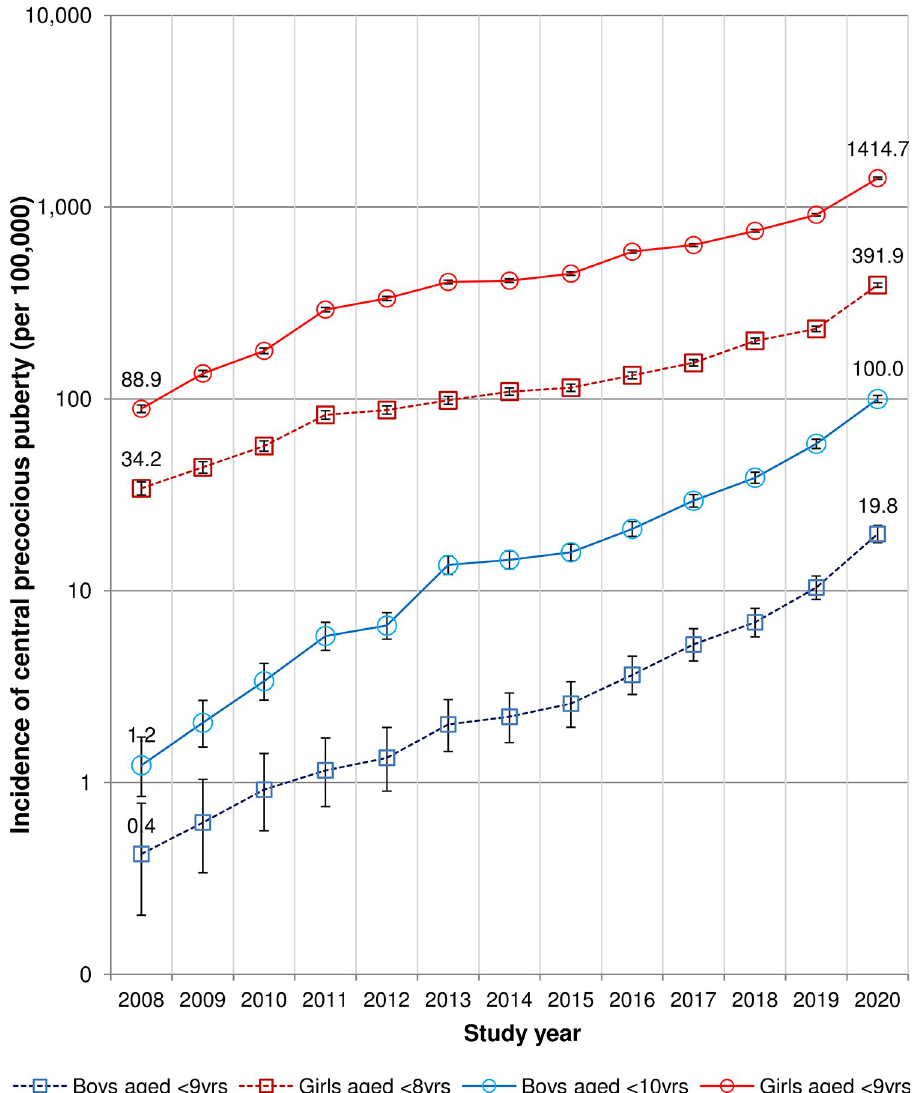
Fig 1. The annual incidence of central precocious puberty. The error bars show the 95 percent confidence intervals for the incidence estimates. trends were observed, with a 49.5-fold rise in the annual incidence of CPP in boys from 0.4 to